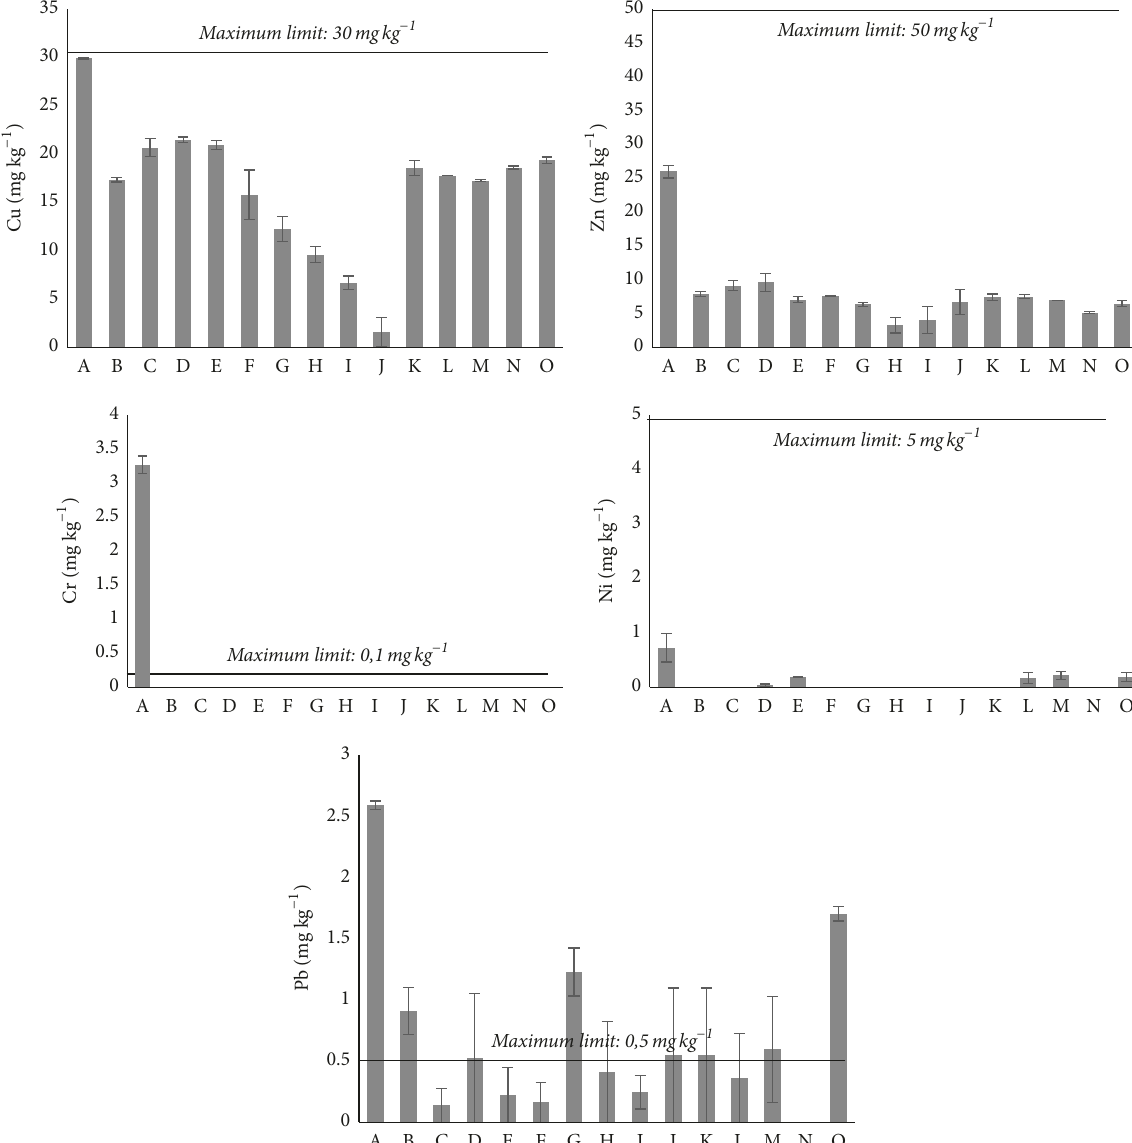
Figure 2: Mean content of heavy metals in roasted ground coffee samples and maximum contents establish by Brazilian legislation [18, 19].